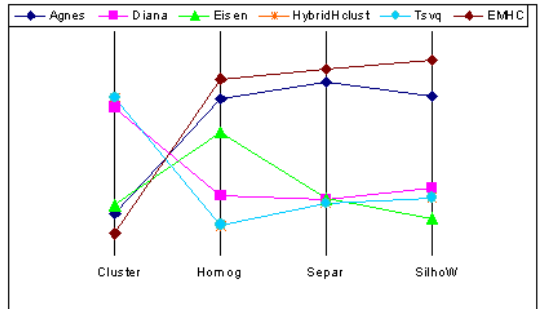
Figure 6: A view of parallel coordinates for four measures, representing six curves with values scored by each method in Table 3 ( lung data set).